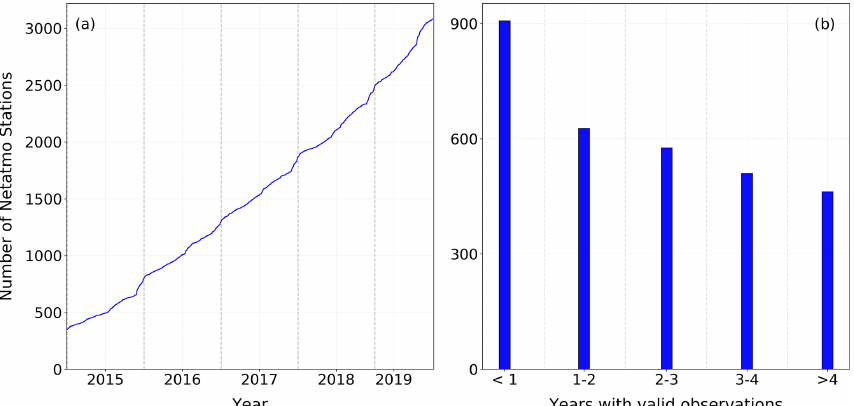
Figure 2. Development of the number of available online Netatmo rain gauges (a) and length of available valid hourly observations in Baden-Württemberg (b)